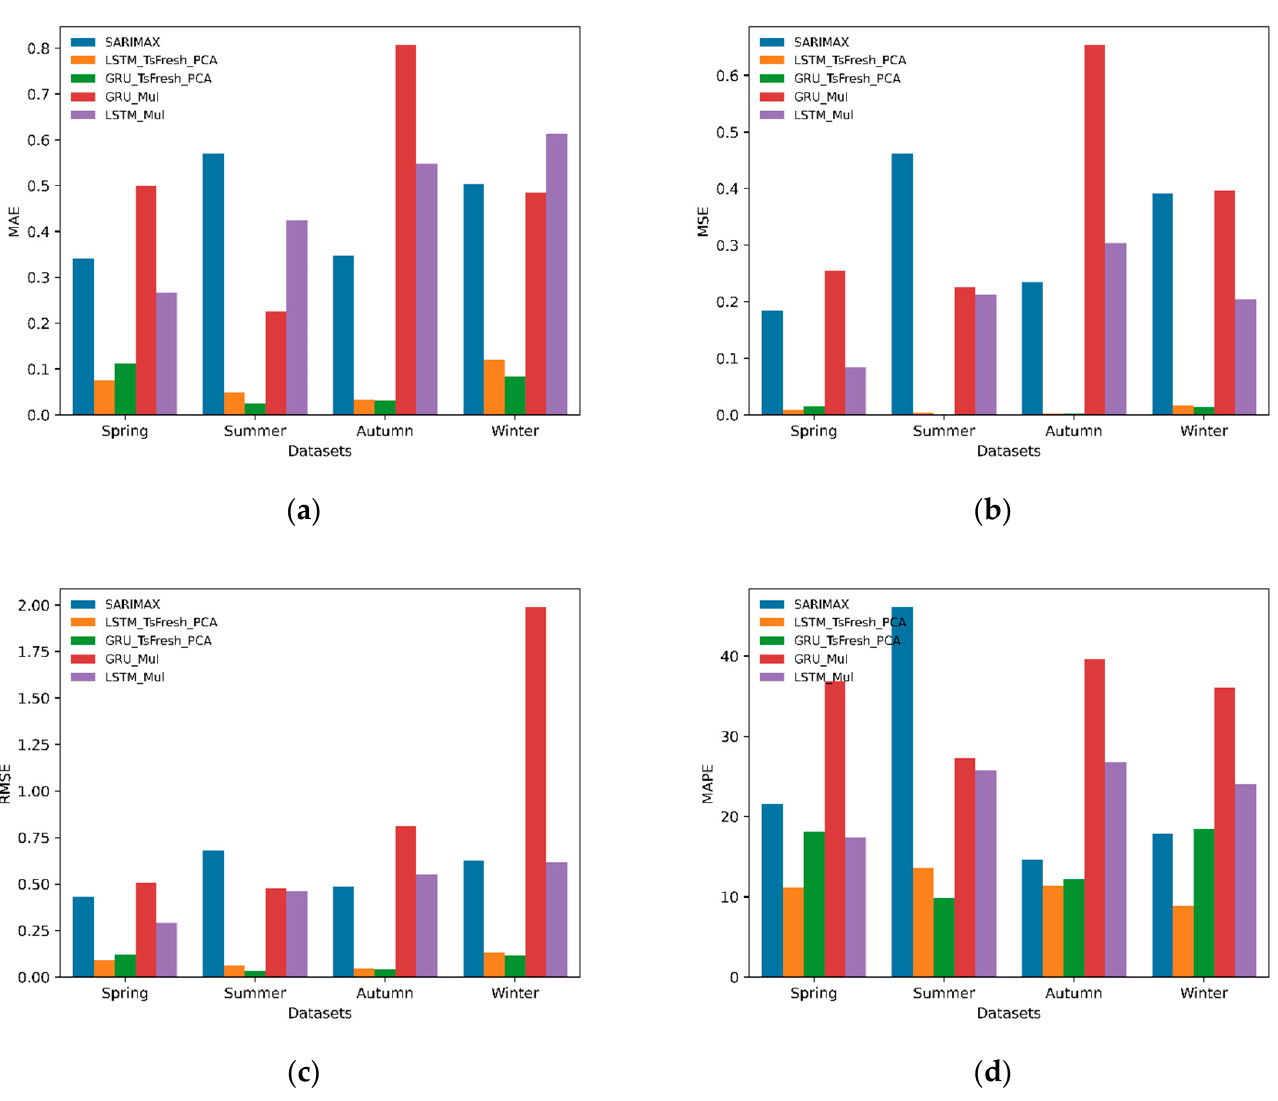
Figure 12. Comparison of the evaluation of different models. ( a ) MAE comparison of different models; ( b ) MSE comparison of different models; ( c ) RMSE comparison of different models; ( d ) MAPE comparison of different models.